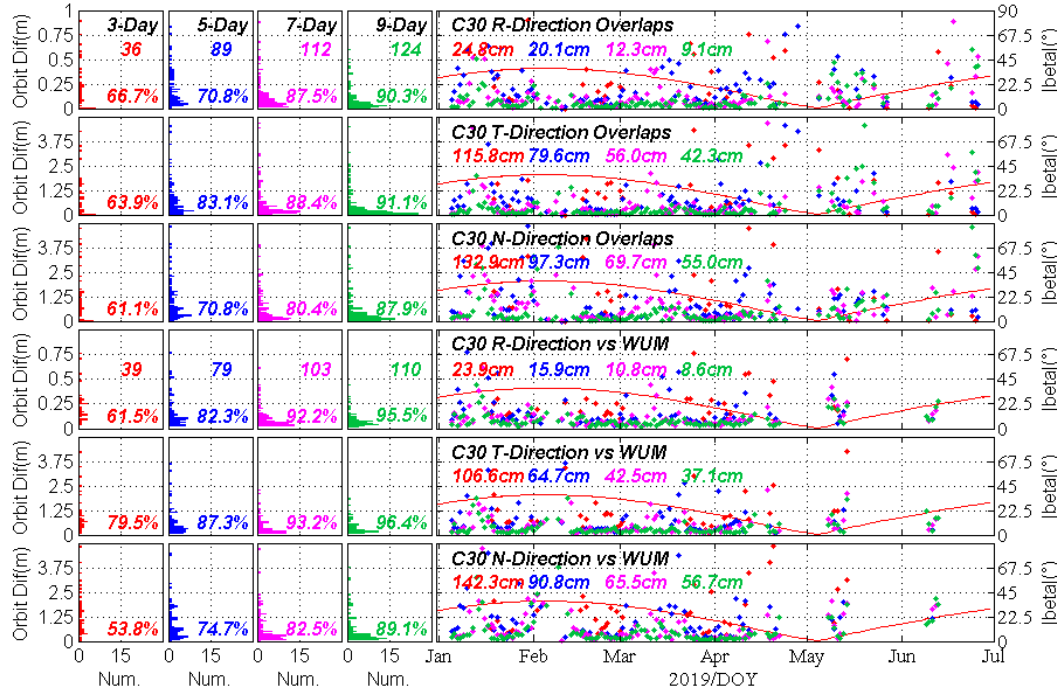
Figure 14. The results of SLR-only orbit determination for C30.